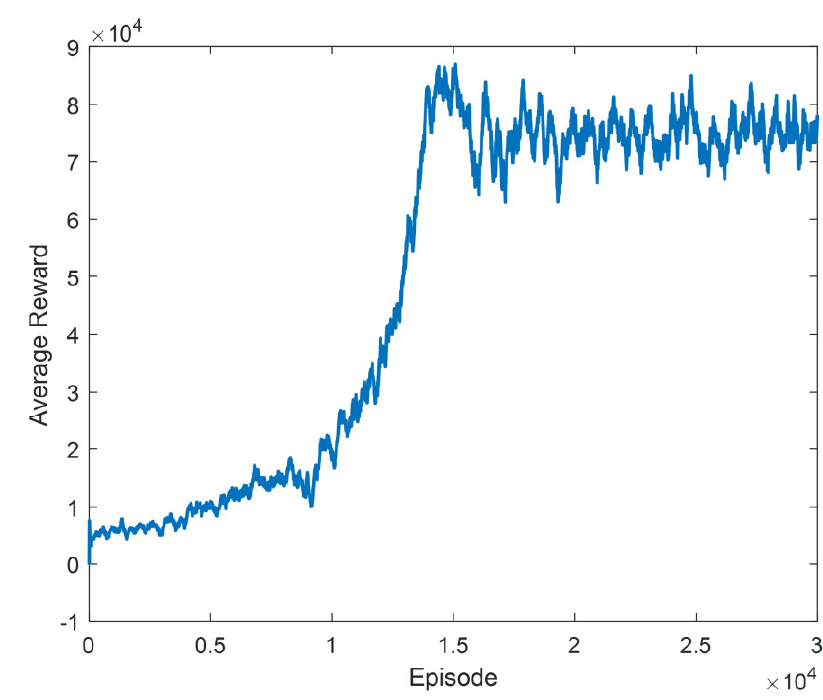
Figure 17. Average reward graph with an average of last 200 episodes. When the training results in Figure 17 are examined, it is seen that the average reward increases exponentially up to the roughly 16,000th episode. Afterwards, the average reward remained within a specific range. During the training, it has been observed that it converges to the parameters that can perform many successful walking processes. However, action sequences consisting of the actions in Table 8 were obtained repeatedly in at least the last 9000